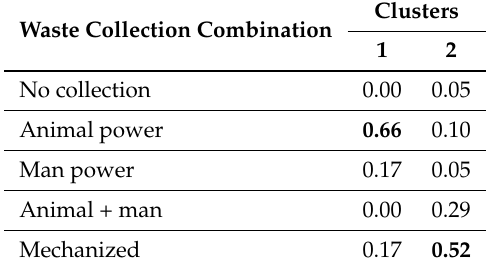
Table 8. Distribution of the categorical variable “waste collection combination”.